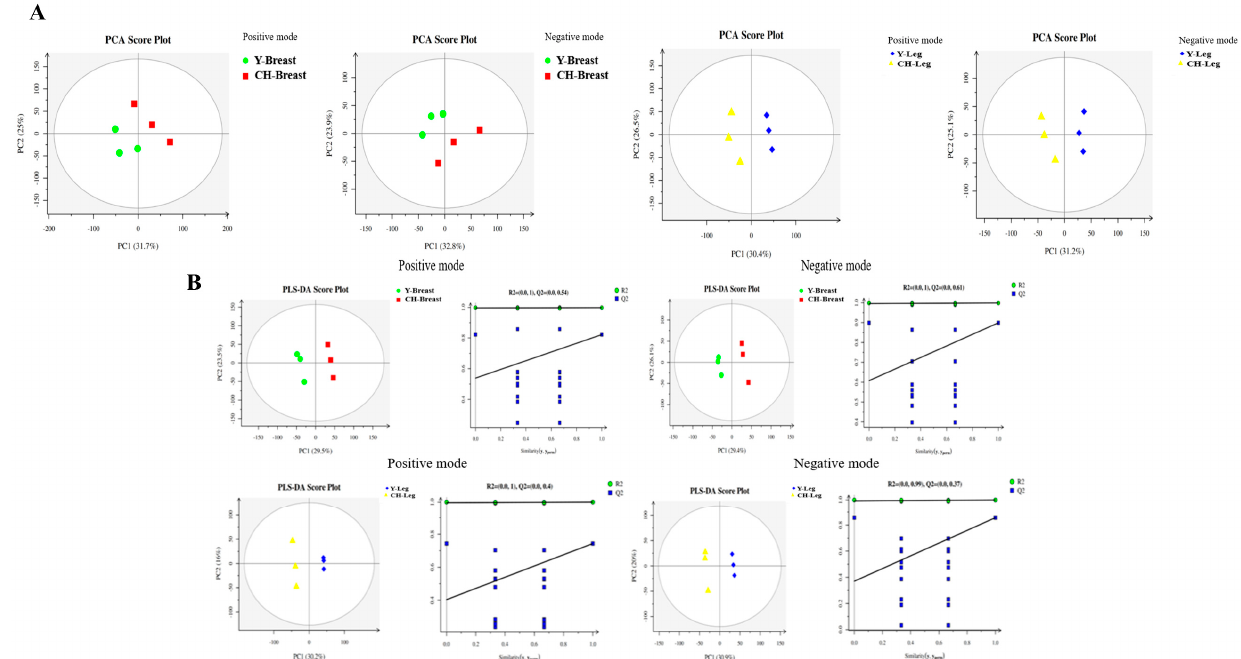
Figure 3. PCA score and PLS − DA. ( A ) PCA score of positive and negative ion mode in muscle tissue of two kinds of chickens. ( B ) PLS − DA score chart and replacement test chart of positive and negative ion mode in muscle tissue of two kinds of chickens.